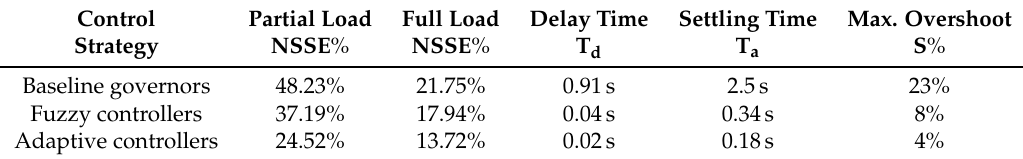
Table 6. Monte Carlo analysis for the considered control